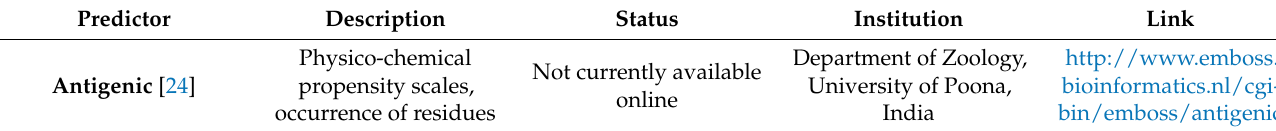
which was developed in 2017. This method is based on a random forest algorithm and differs from its predecessor in that it was trained only on epitope data derived from crystal structures. Another promising algorithm is iBCE-EL [46], which is an ensemble learning framework combining Extremely Randomized Tree (ERT) and Gradient Boosting (GB) classifiers. An overview of all methods is presented in Table 1 below. Table 1. Linear B-cell epitope predictors in chronological order, alongside a short description of their methodology, their current status and their web page. After researching the relevant publications, we gathered up all the linear B-cell epitopes predictors we could find in this fairly complete, but not exhaustive catalogue. For every method we reference the source material to determine their methodology, which we have summed up for each predictor in a short description. For every predictor we also checked their availability status, as of writing this review, and categorized them regarding their general and current availability online as tools, as well as their obtainability as standalone software packages. We also provide the institution in which they were developed. In the last column, we provide the website links for each method, when